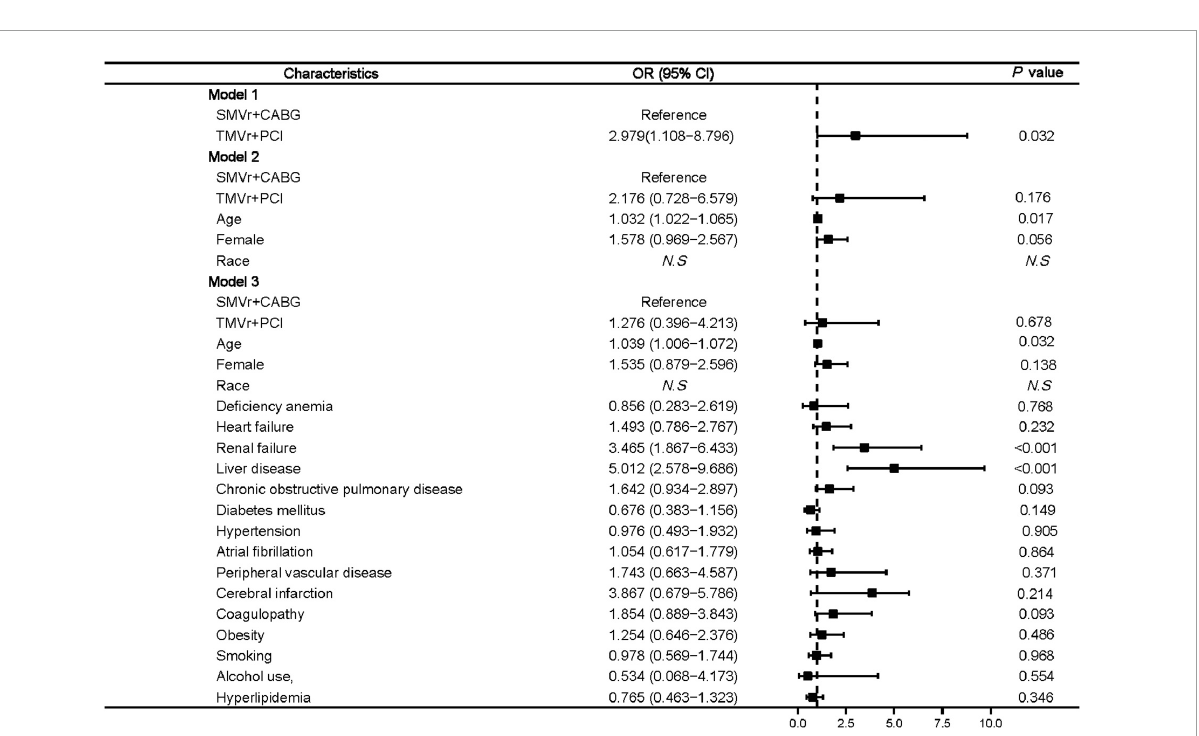
FIGURE3 Predictors of mortality in mitral valve insufficiency patients undergoing SMVr + CABG or TMVr + PCI. TMVr indicates transcatheter mitral valve repair; SMVR indicates surgical mitral valve repair; CABG indicates coronary artery bypass grafting; PCI indicates percutaneous coronary stent implantation; model 1 indicates the univariate regression analysis; model 2 adjusted for SMVr + CABG, TMVr + PCI, age, female, race; model 3 adjusted for SMVr + CABG, TMVr + PCI, age, female, race, deficiency anemia, heart failure, renal failure, liver disease, chronic obstructive pulmonary disease, diabetes mellitus, hypertension, atrial fibrillation, peripheral vascular disease, cerebral infarction, coagulopathy, obesity, smoking, alcohol use, and hyperlipidemia.